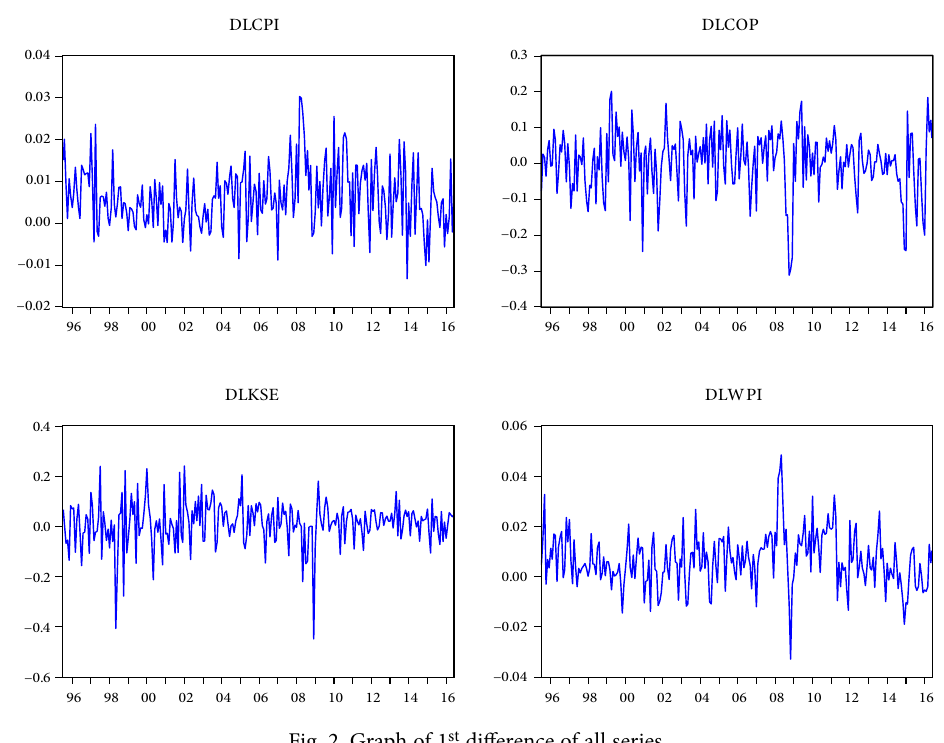
Fig. 2. Graph of 1 st difference of all series Source: Authors’ calculations. Table 2. VAR Lag order selection